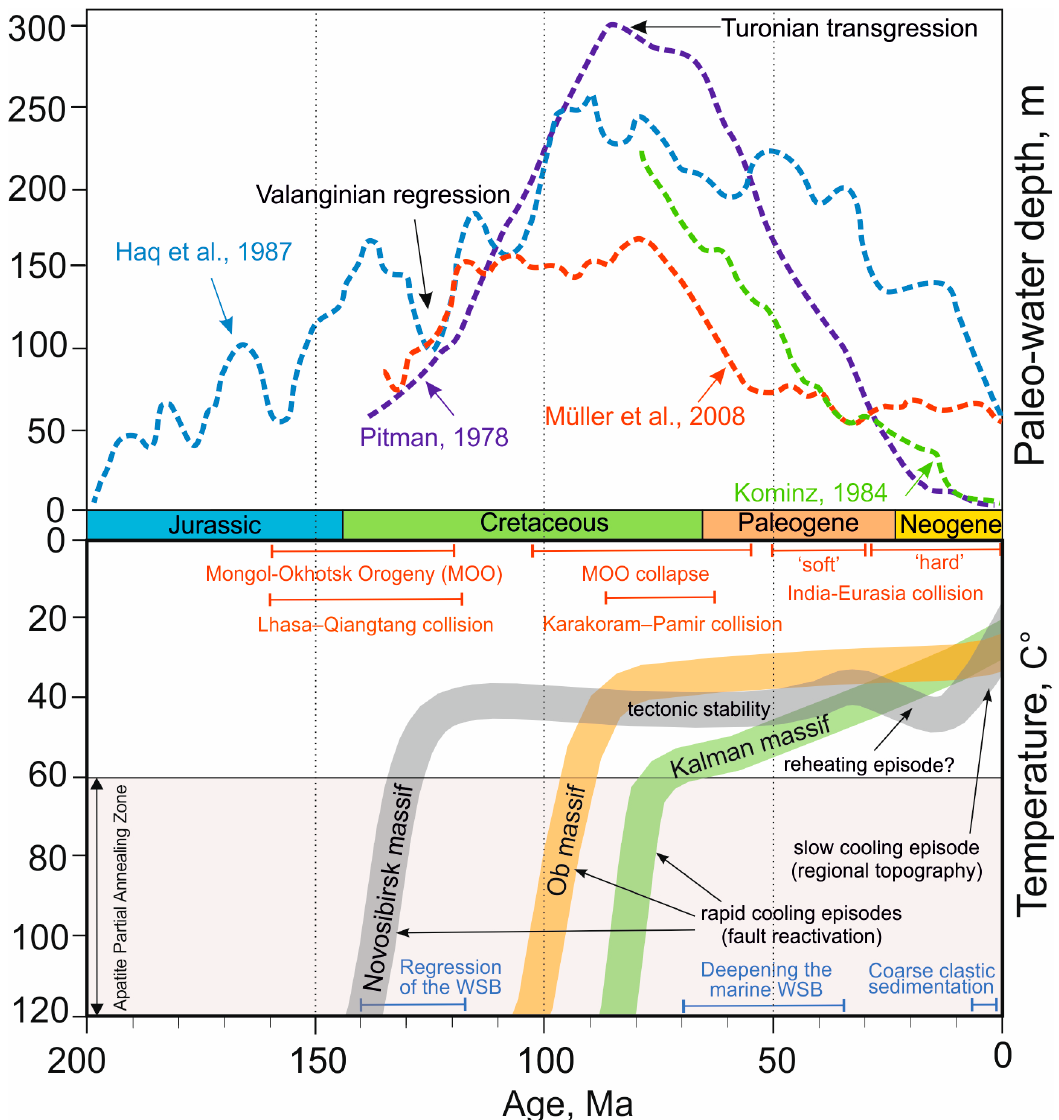
Figure 7. Correlation of the multiple sample thermal history models (expected t-T trends) of the Ob (orange line), Novosibirsk (grey line), and Kalman (green line) massifs (below) with Mesozoic and Cenozoic tectonic events (red, atop), main sedimentation stages in the West Siberian Basin (blue, bottom), and mean paleo-water depth (above). Global eustatic level from different studies [69–72] after [6].